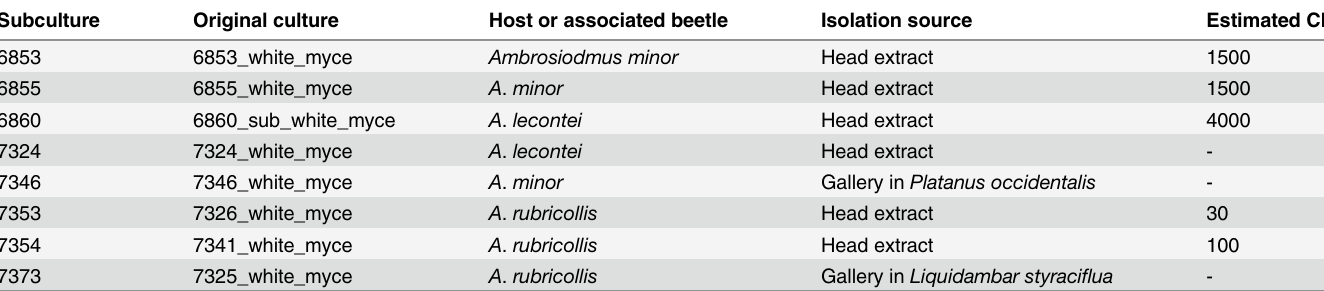
Table 1. Cultures of Flavodon cf. flavus and host